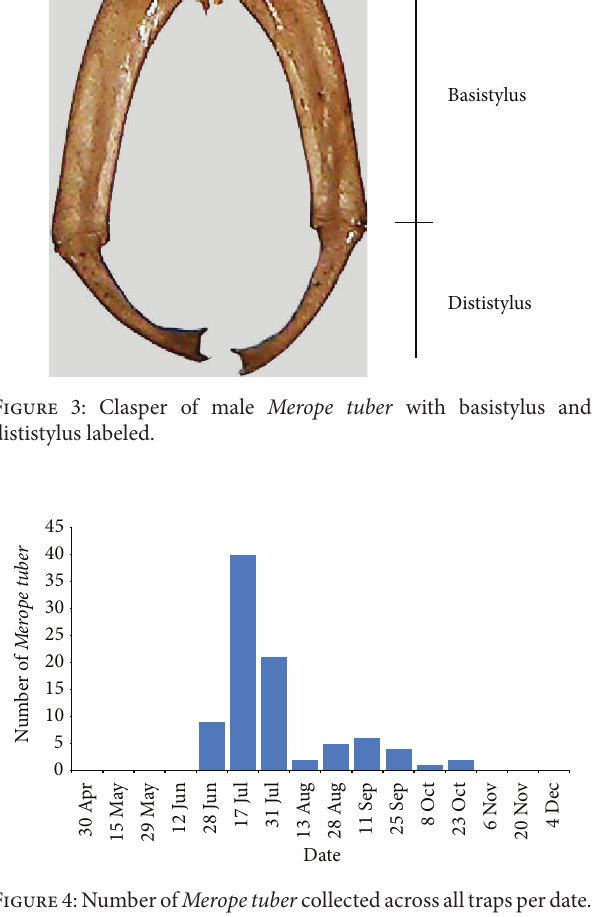
Figure4:Numberof Meropetuber